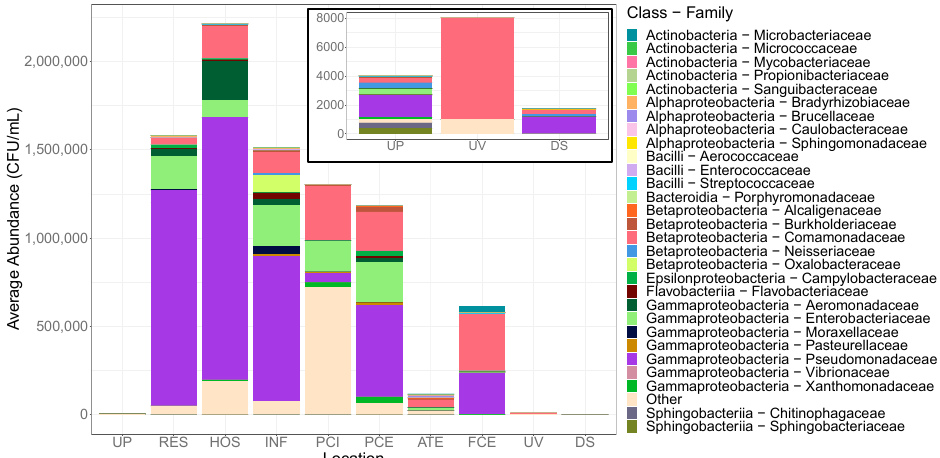
Figure 3. CFU/mL normalized counts of 16S rRNA gene relative abundance data for antibiotic-resistant communities at each sampling location. Combined Mallard and Sugar Creek samples at each sampling location including combined antibiotic-amended cultured communities. Relative abundance determined through 16S rRNA gene sequencing was multiplied by CFU/mL at each location to determine estimated taxonomic abundances. The inset shows the enlarged taxonomic abundances for the upstream, UV-treated, and downstream locations. Families making up <1% of the total community at each site were excluded. UP, upstream; RES, residential sewage; HOS, hospital sewage; INF, sewage influent; PCI, primary clarification influent; PCE, primary clarification effluent; ATE, aeration tank effluent; FCE, final clarification effluent; UV, UV treated effluent; DS, downstream.